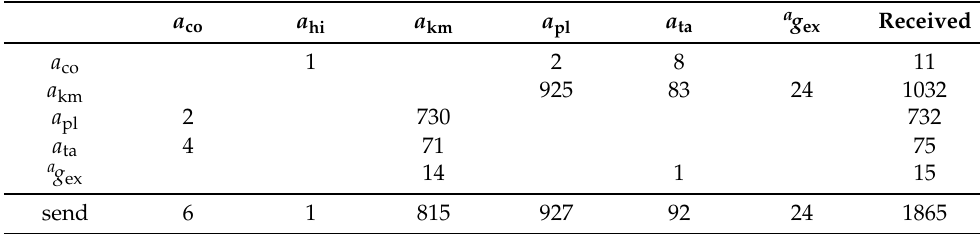
Table 8. Number of messages sent and received by